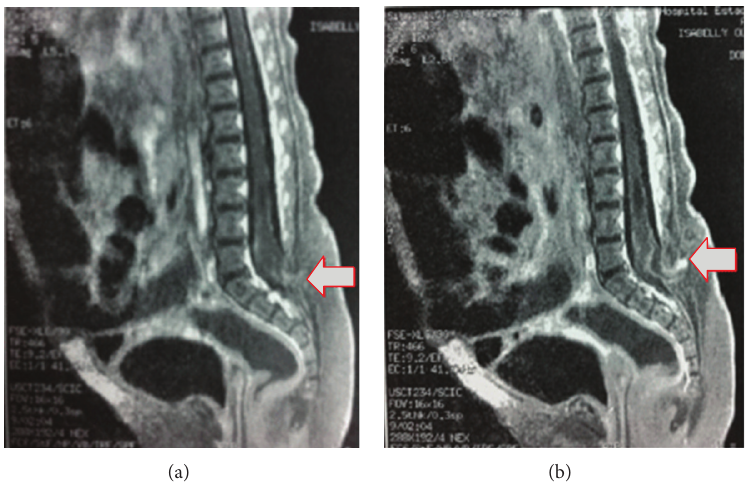
Figure 3: (a) and (b) Magnetic resonance imaging on the spine in the sagittal plane, showing a closure defect of the medullary canal at the level of the sacral region (S1) (white arrows), along with the presence of a posterior image with hypersignal in T1 and T2, compatible with a lipoma (red